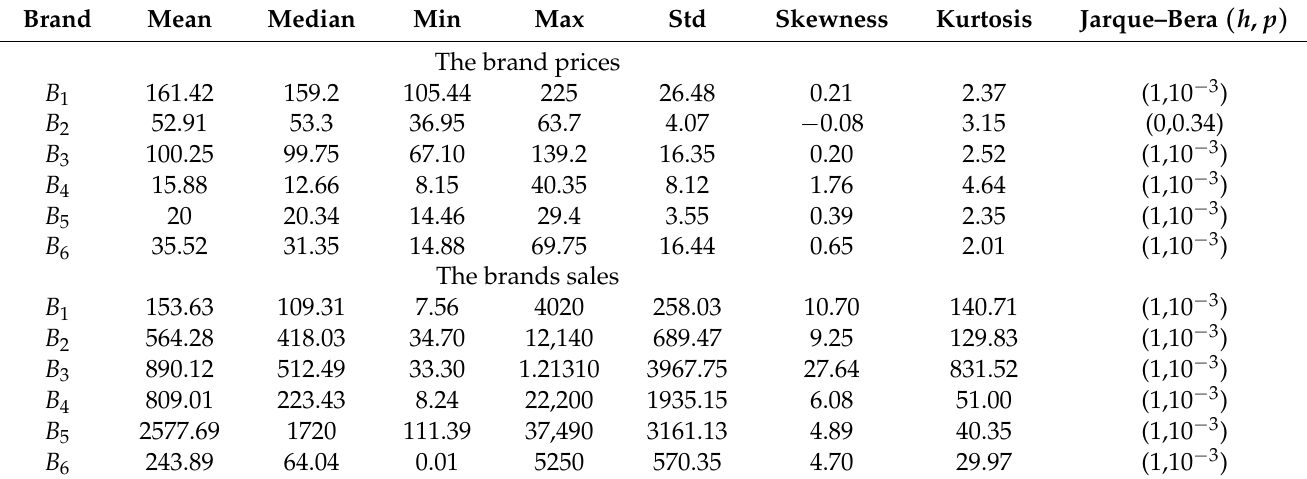
Table 2. Descriptive statistics for brands B i , 1 ≤ i ≤ 6, prices and